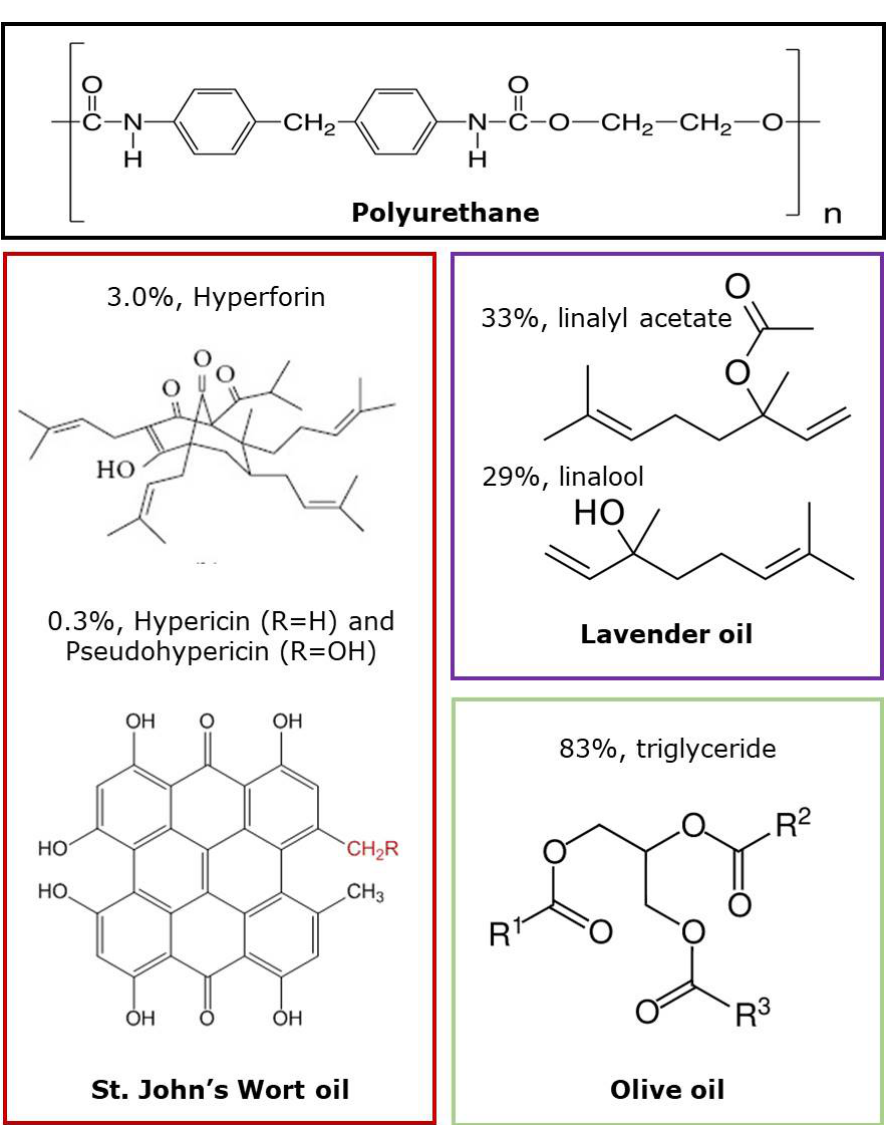
Figure 1. Chemical structure of the polymer and the main components in EOs used in this